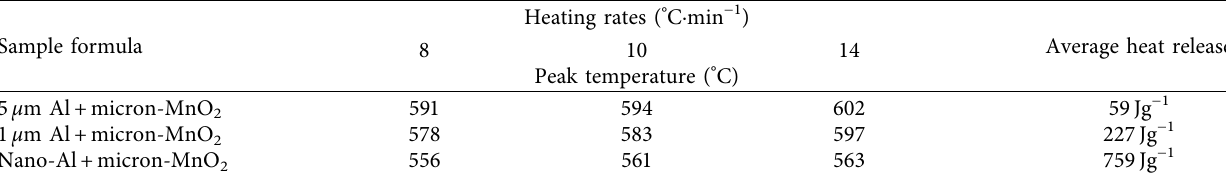
Figure 8: DSC curves of thermite samples at different heating rates: (a) 5 μ m Al +micron-MnO 2 thermite, (b) 1 μ m Al +micron-MnO 2 thermite, and (c) nano-Al+micron-MnO 2 thermite. Table 1: DSC parameters of first exothermic